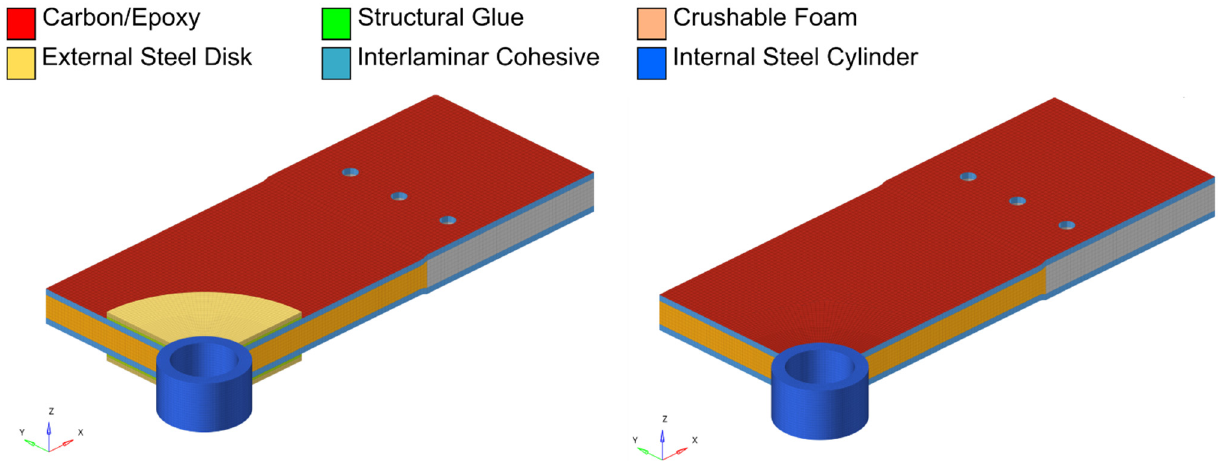
Figure 1. Section of proposed composite joint configuration: (SX) Advanced Joint; (DX) Simple Joint.